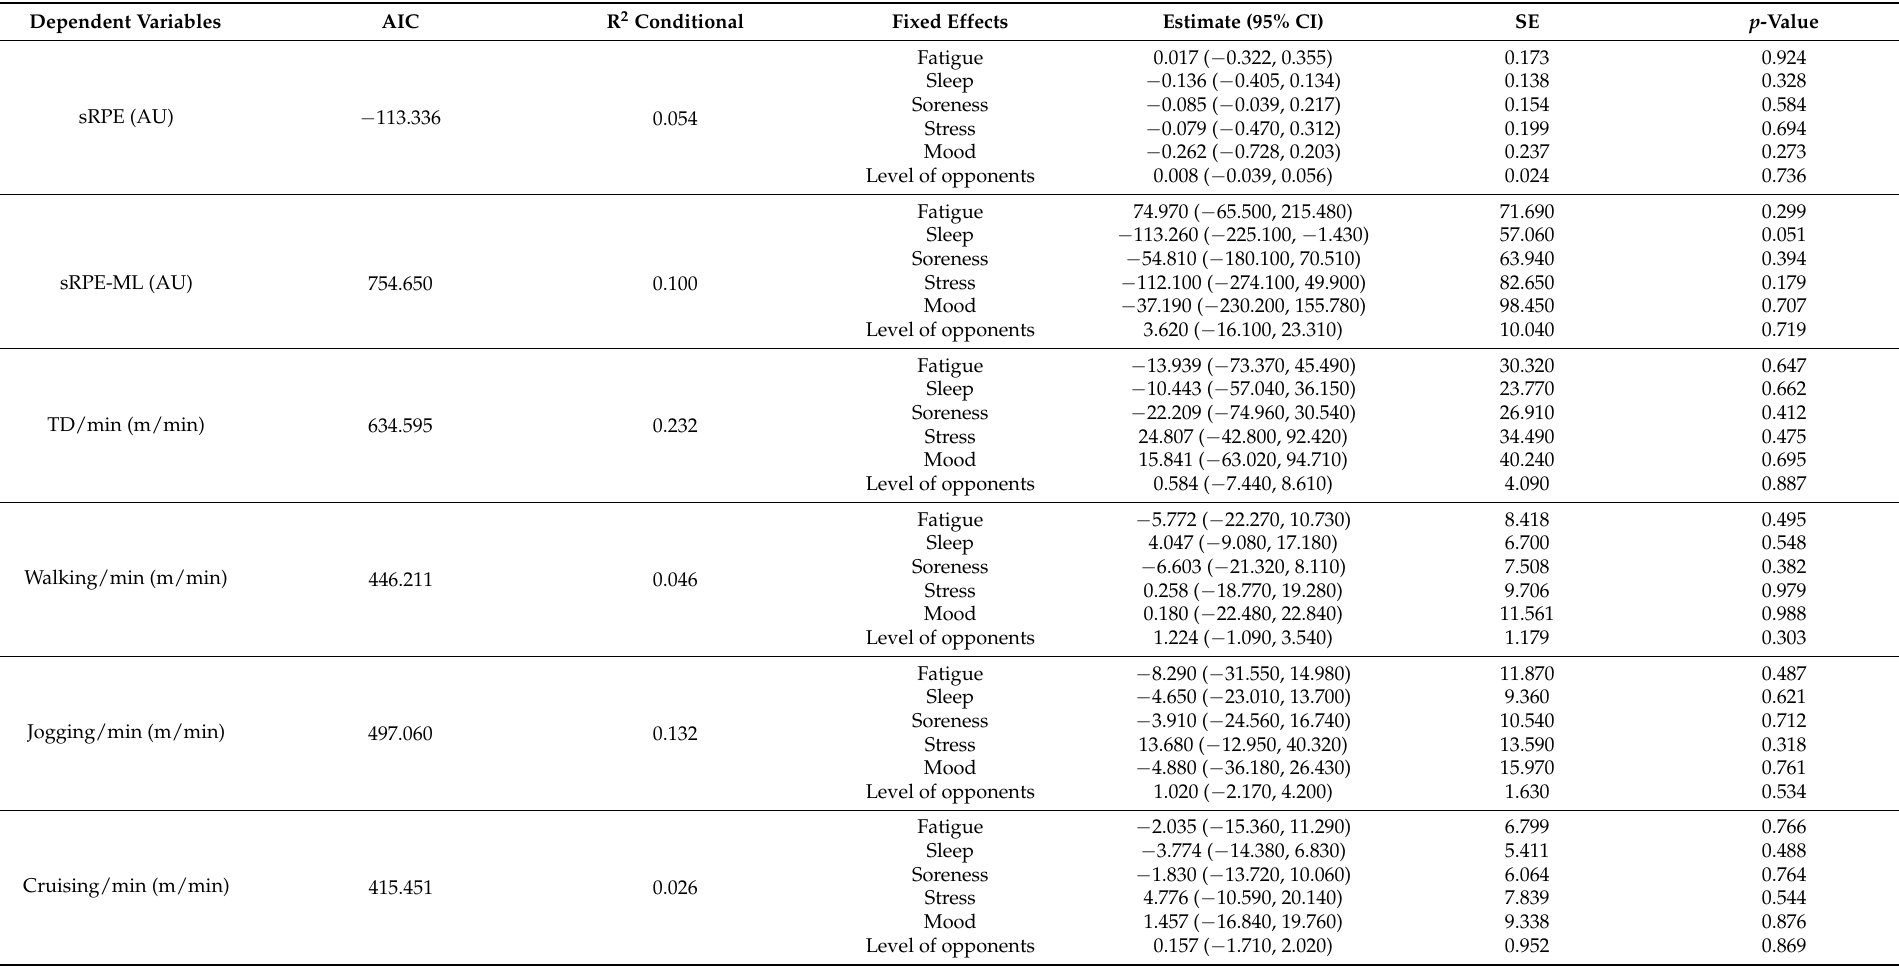
Table 3. The effect of previous-day well-being and level of opponents on match load